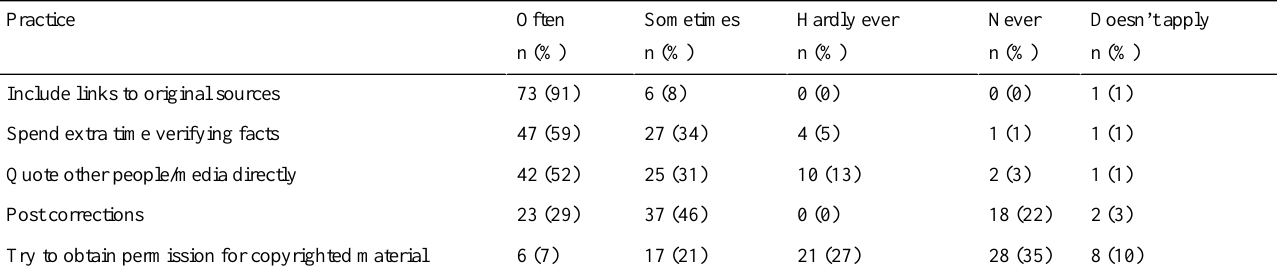
Table 4. Representation of practices associated with journalism among the responding medical bloggers (N=80)